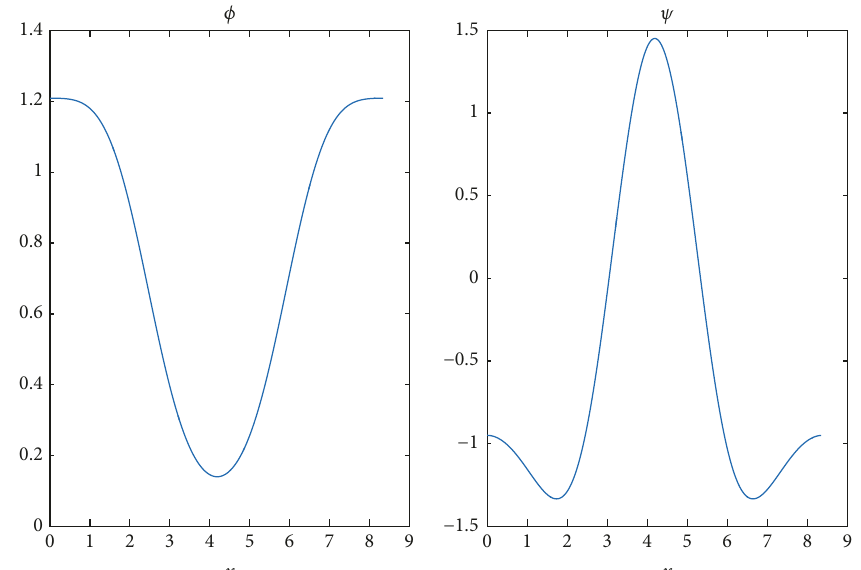
Figure 7: Approximations of the functions 𝜙, 𝜓 in the travelling wave solution (39) with 8 Newton’s iterations. The model’s parameters are 𝛼 = 𝛽 = 𝛾 = 1 , 𝑤 = 1.5 , and wave speed 𝑐 = 1.5 and the fundamental period is 𝐿 ≈ 8.38 .